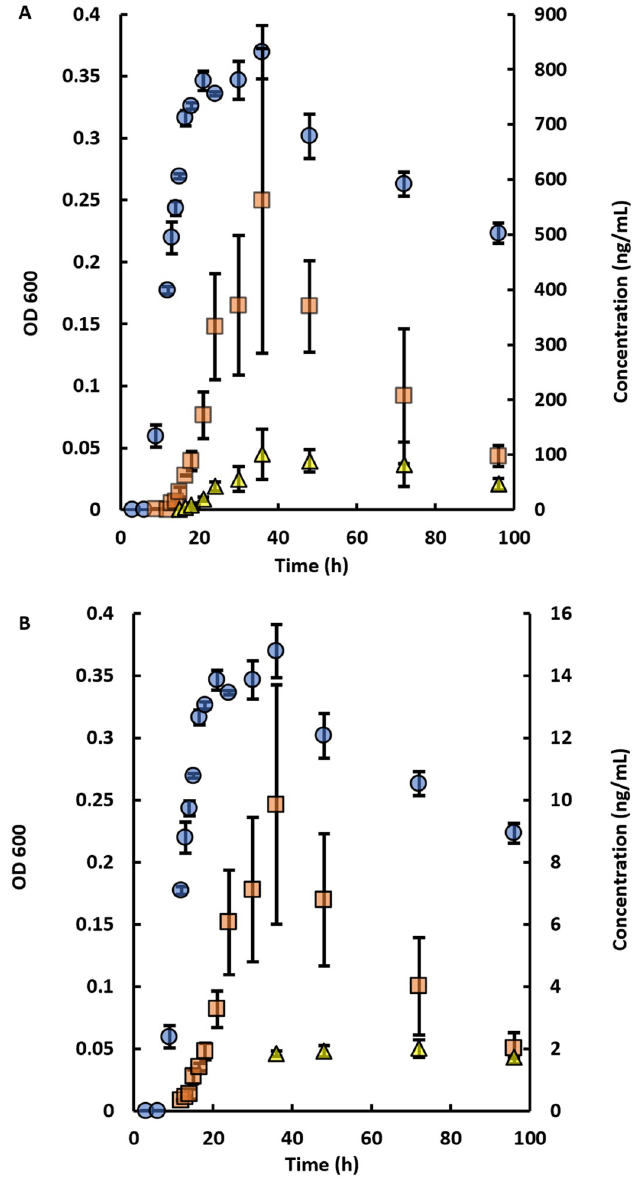
Fig 6. Growth curves showing the OD 600 and production of with respect to time in P . aeruginosa . (A) D,L-A-C4 and (B) D,L-A-C6-HLs. Average of triplicates shown with standard deviations as error bars. Blue circle indicates the OD 600 reading with the measured values in the left y-axis. Red square indicates the concentration of L-A-C4 (A) and L-A-C6 (B) with measured values in the right y-axis. Yellow triangle indicates the concentration of D-A-C4 (A) and D-A-C6 (B) with measured values in the right y-axis. Concentrations of D-A-C4 and D-A-C6 were increased by 10 times for clarity.